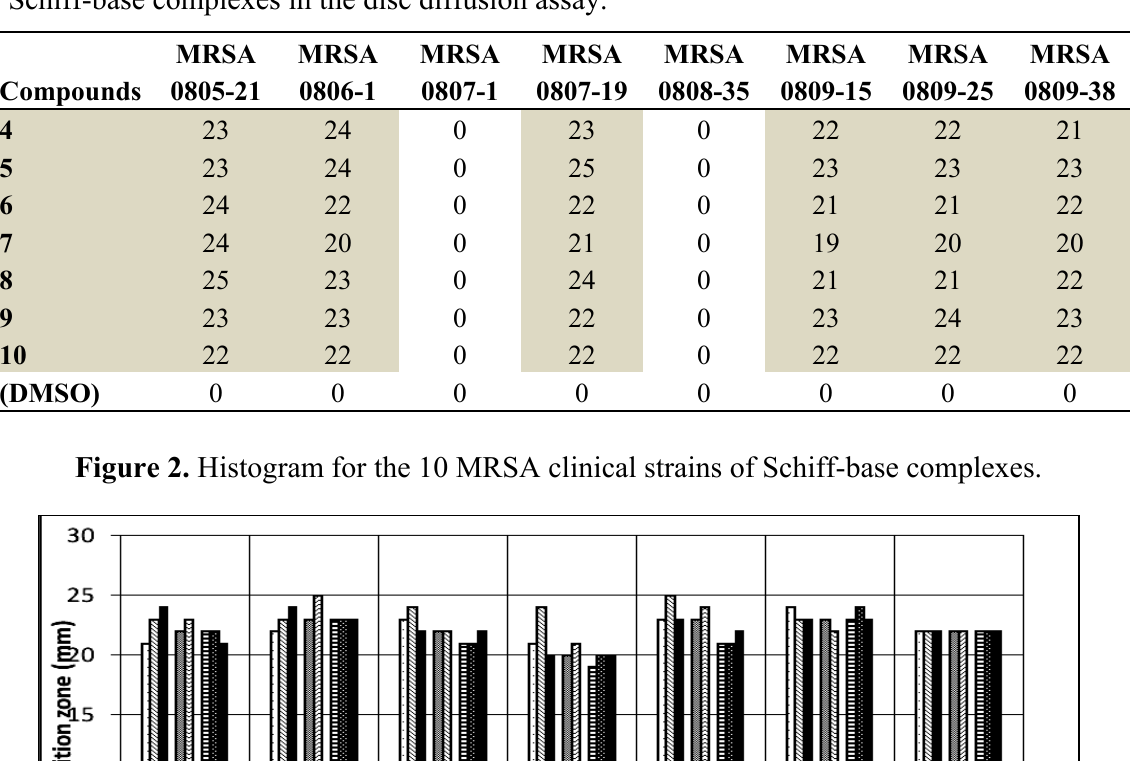
Table 5. Varying responses of the eight MRSA clinical strains towards the seven selected Schiff-base complexes in the disc diffusion assay.